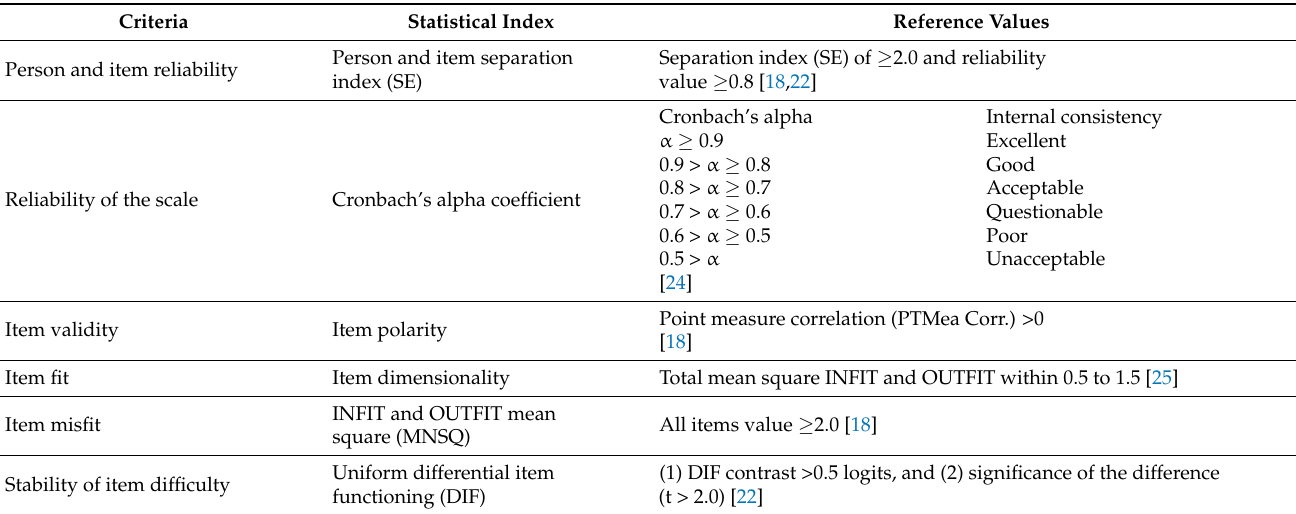
Table 1. Summary of analysis applied regarding item validity and reliability assessment.